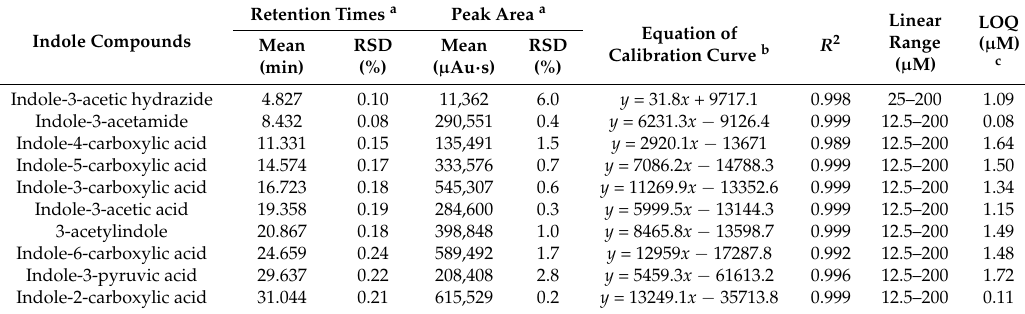
Table 2. Response characteristics of indole compound standards using HPLC.